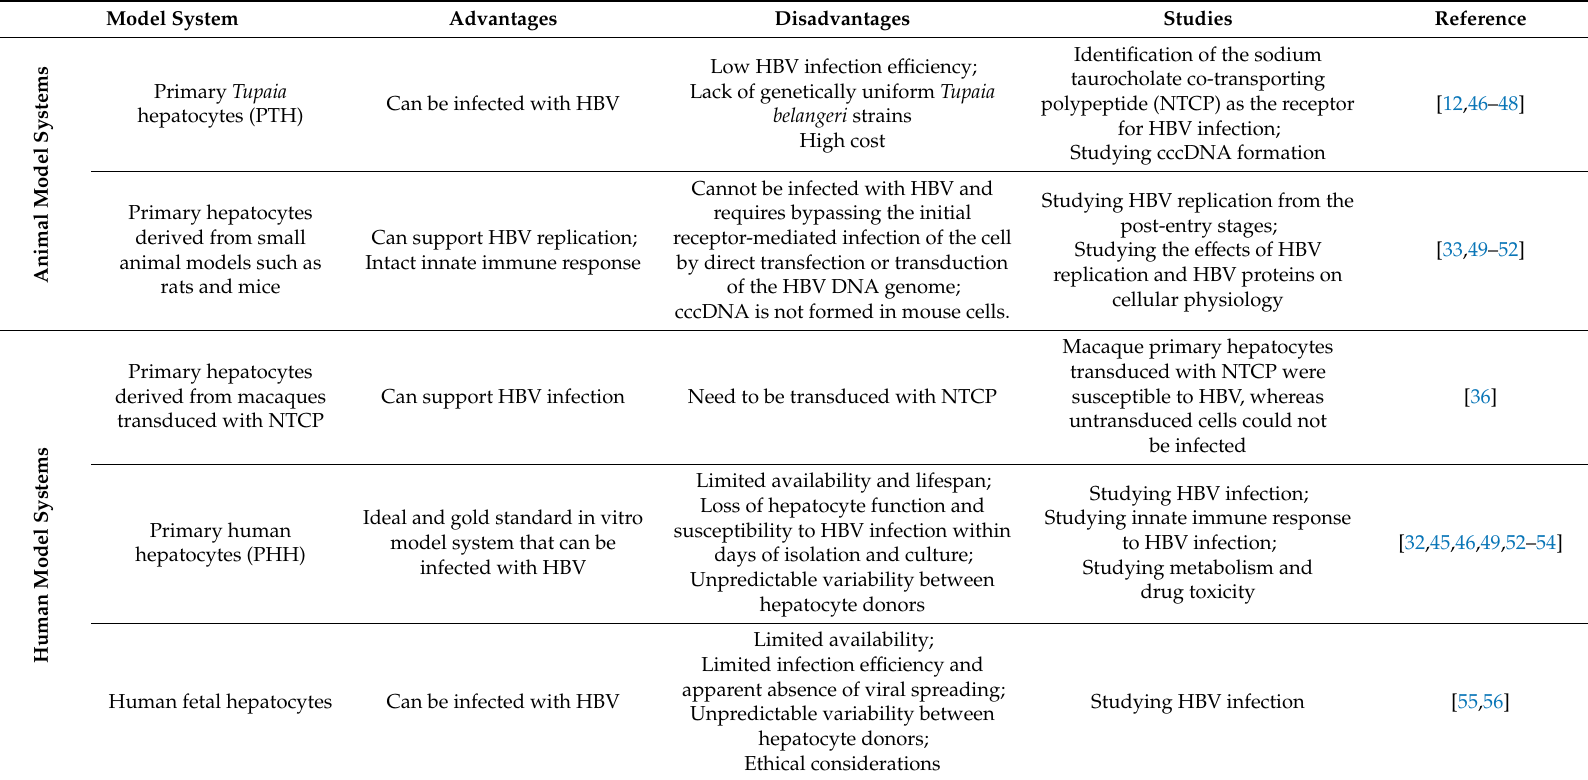
Table 1. Summary of the in vitro model systems suitable for studying hepatitis B virus (HBV)